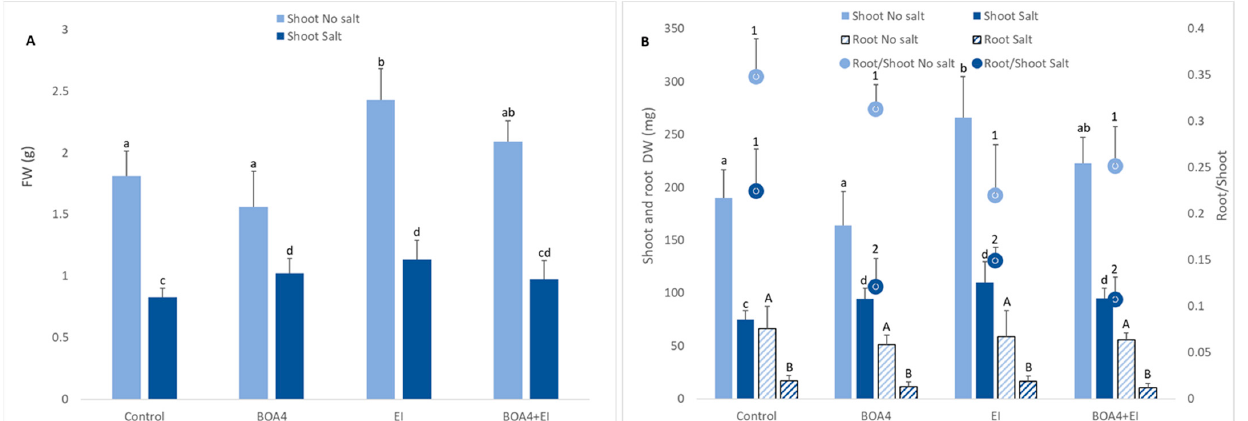
Figure 2. Shoot and root biomass and root/shoot ratio of plants collected at day 50. In panel ( A ), shoot fresh weight (FW) is depicted. No-salt and salt stress conditions are represented by light-colored and dark-colored columns, respectively. In ( B ), shoot and root dry weights are represented by filled and pattern columns, respectively. No-salt and salt stress conditions are represented by light-colored and dark-colored columns, respectively. Filled circles in ( B ) represent root/shoot ratio, light-colored and dark-colored circles correspond to no-salt and salt stress conditions, respectively. BOA4: Achromobacter xylosoxidans strain BOA4; EI: Enteromorpha intestinalis extract; BOA4 + EI: Achromobacter xylosoxidans strain BOA4 plus Enteromorpha intestinalis extract. Bars represent standard deviation. Different lower-case letters, upper-case letters or numbers above the bars indicate means that differ significantly ( p < 0.001).